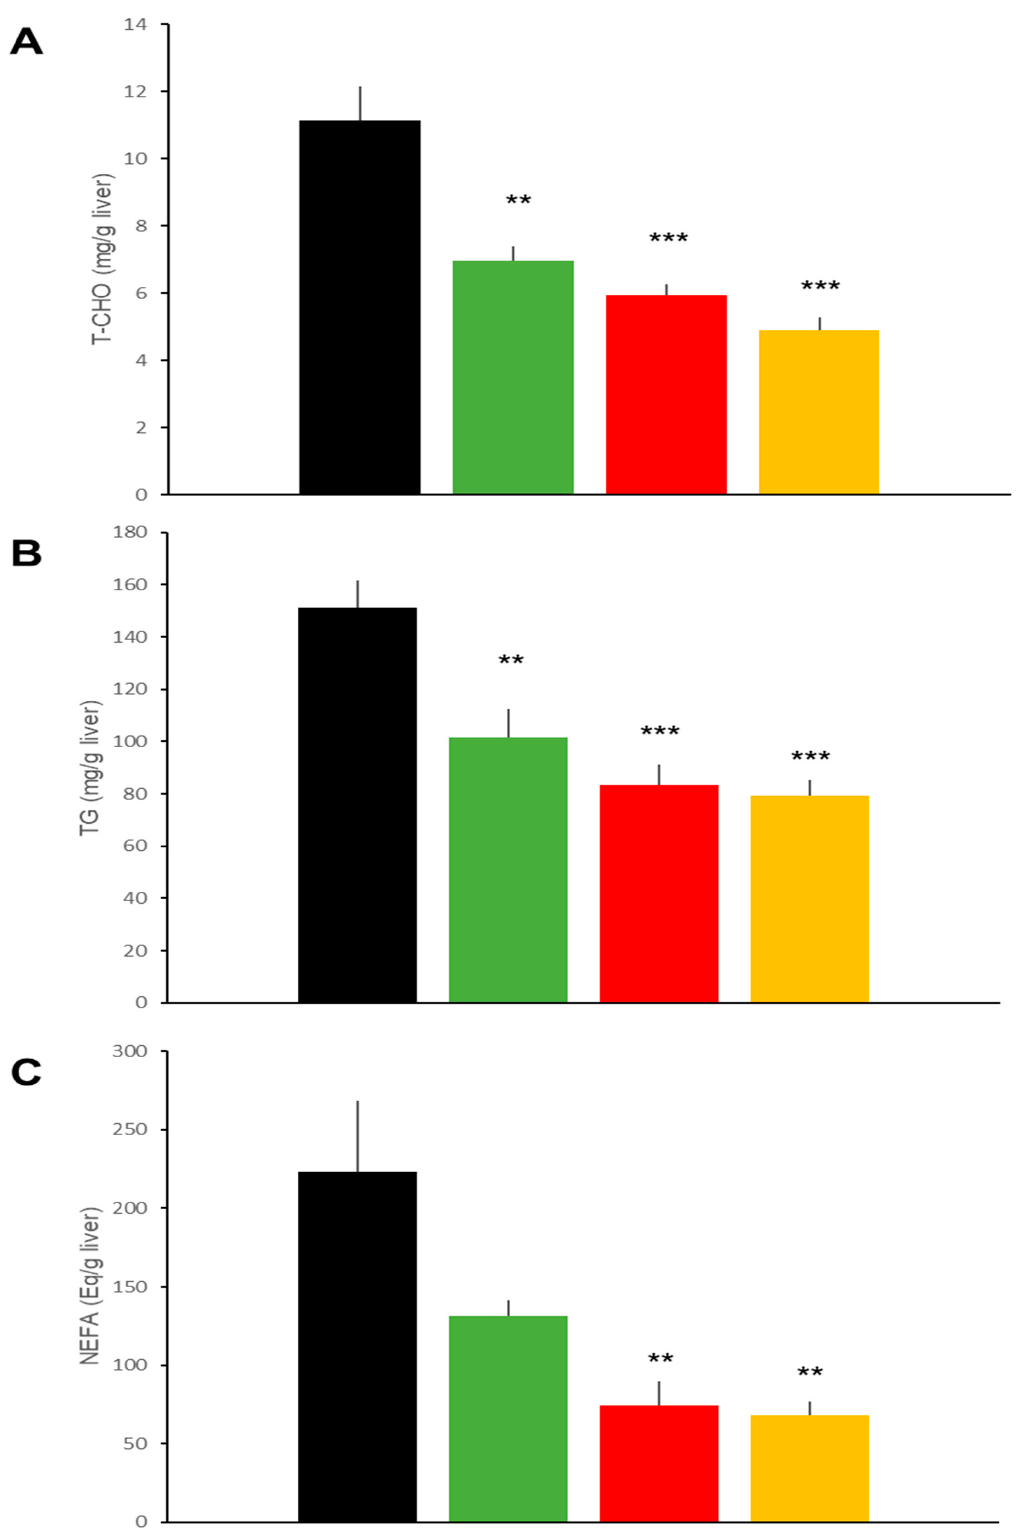
Figure 9. Effects of treatments with liraglutide and/or ipragliflozin on hepatic lipid contents in db/db mice. Hepatic total cholesterol ( A ), TG ( B ), and non-esterified fatty acid ( C ) contents of vehicle-treated db/db mice and of db/db mice treated with liraglutide and/or ipragliflozin. Data represent mean ± SE, n = 6, ** p < 0.01, and *** p < 0.001 vs. control group.